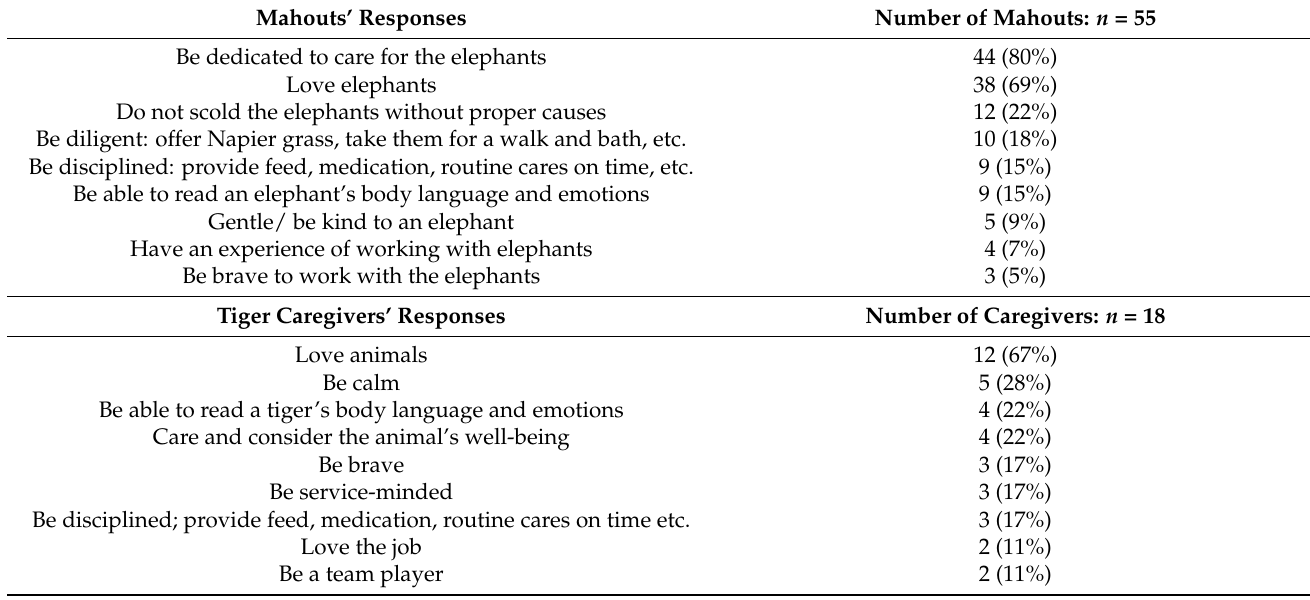
Table 6. Essential qualities for animal caregivers (among three choices, each provided by at least two